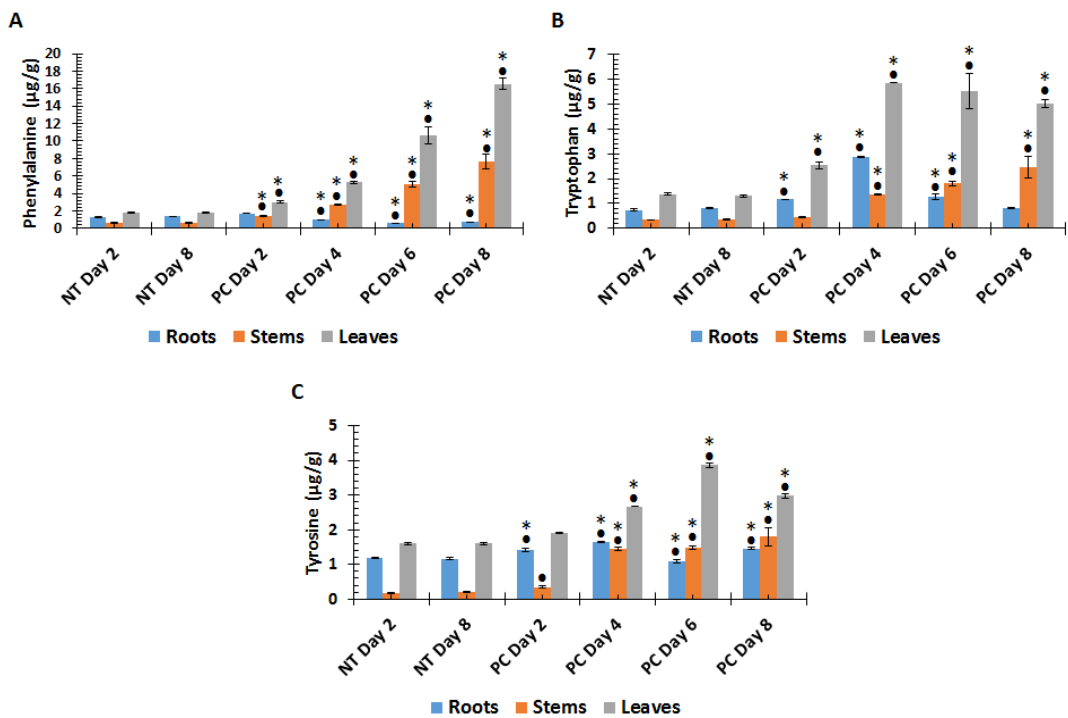
Figure 1. Changes in aromatic amino acid content in tomato plant tissue harvested at different time points following Phytophthora capsici (PC) inoculation in stems vs. non-treated (NT) plants. ( A ): Phenylalanine, ( B ): Tryptophan, ( C ): Tyrosine. Upon harvesting, the plants were divided into root, stem, and leaf tissue. Values are means ± SD ( n = 3 independent sampling). Extracts were prepared from 200 mg of pulverised tissue, and all concentrations are expressed as µg/g fresh weight (FW). An asterisk (*) or a dot (•) indicates the statistical significance with a p -value < 0.05 compared with the non-treated plants, with • indicating a comparison between NT day 2 and the PC infection on days 2–8 post-infection, and * a comparison between NT day 8 and the PC infection on days 2–8 post-infection. The results show a time-dependent differential reprogramming of aromatic amino acids levels in the various tissues.